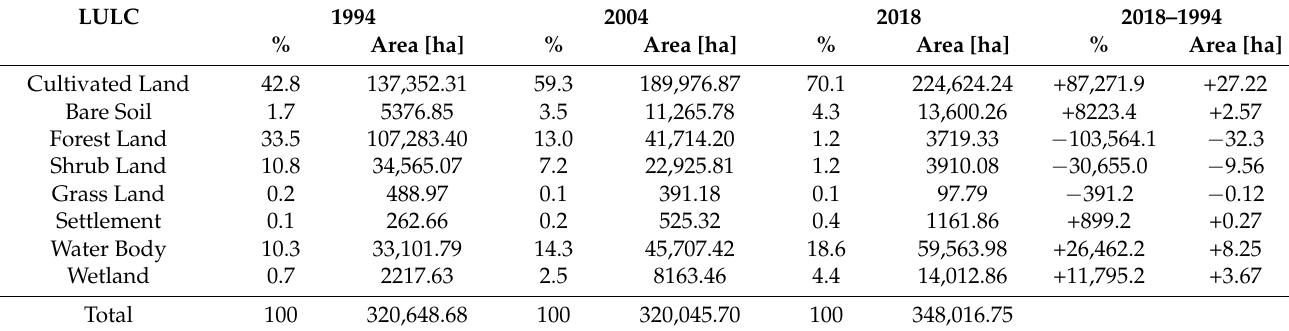
Table 7. LULC in the Fincha’a watershed in 1994, 2004, and 2018. LULCC between 1994 and 2018.